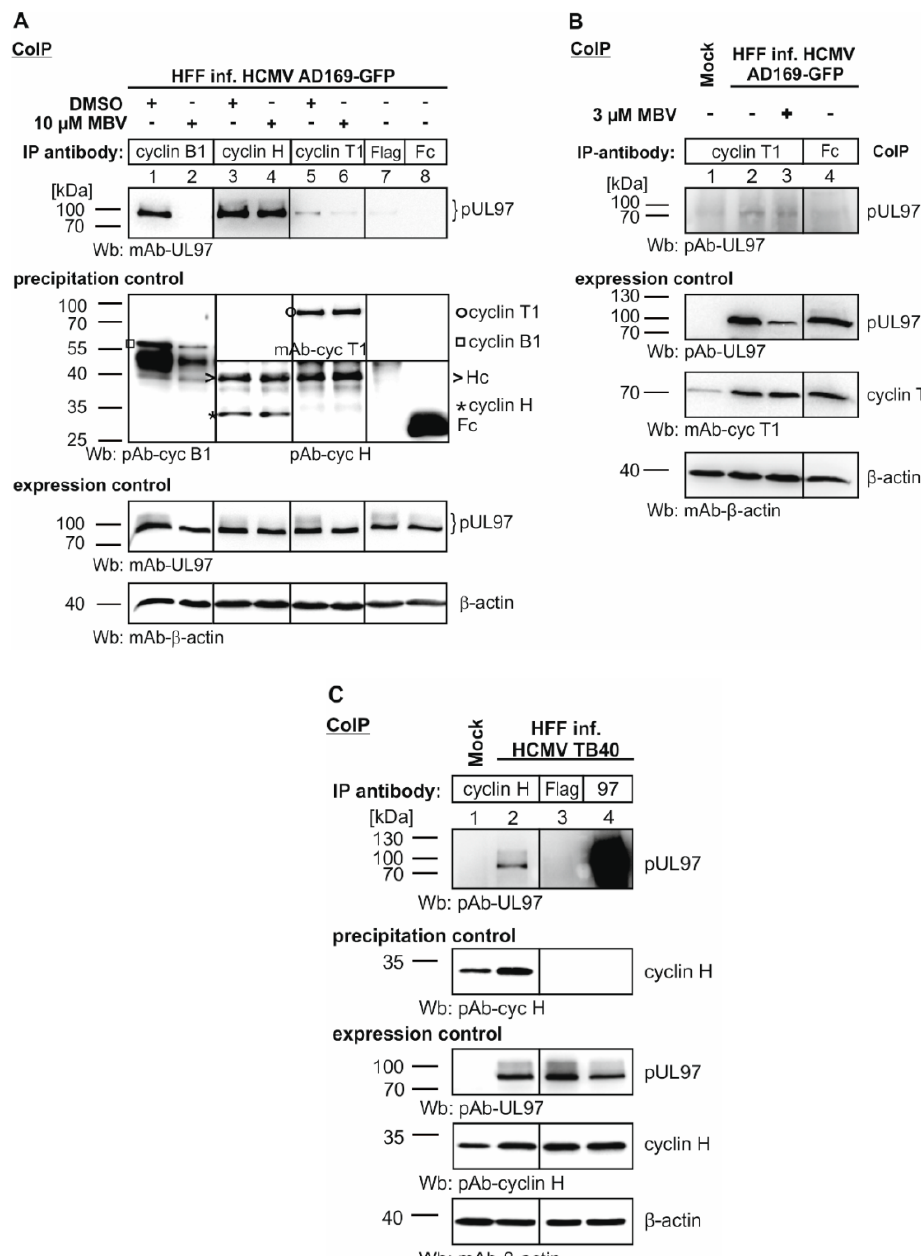
Figure 2. Coimmunoprecipitation of pUL97 with cyclins B1, T1 and H using protein lysates from HCMV ‐ infected cells. ( A ) HFFs were infected with HCMV AD169 ‐ GFP for five days before 10 μ M of pUL97 inhibitor maribavir (MBV) was added to the medium one hour prior to cell harvest. After lysis, endogenous cyclins B1, T1 and H were immunoprecipitated using polyclonal antibodies (panel CoIP). Anti ‐ Flag antibody and a rabbit Fc antibody fragment were used as specificity controls. Levels of expression and CoIP were monitored in parallel by Wb analysis. ( B ) An additional CoIP experiment was performed (harvest of cells four days post ‐ infection) to substantiate the specificity of pUL97 ‐ cyclin T1 interaction. ( C ) HCMV strain TB40 was used to address the question of strain independence of pUL97 ‐ cyclin H interaction (CoIP conditions as in ( A ).